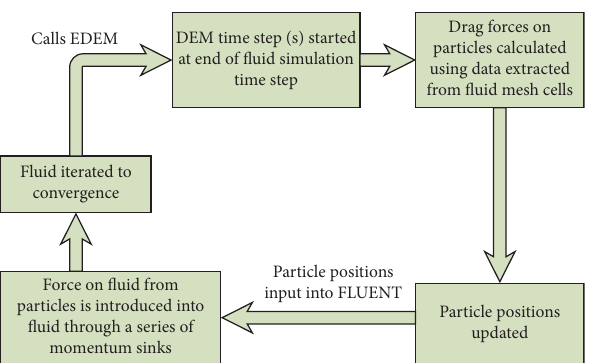
Figure 2: EDEM-FLUENT coupling Process